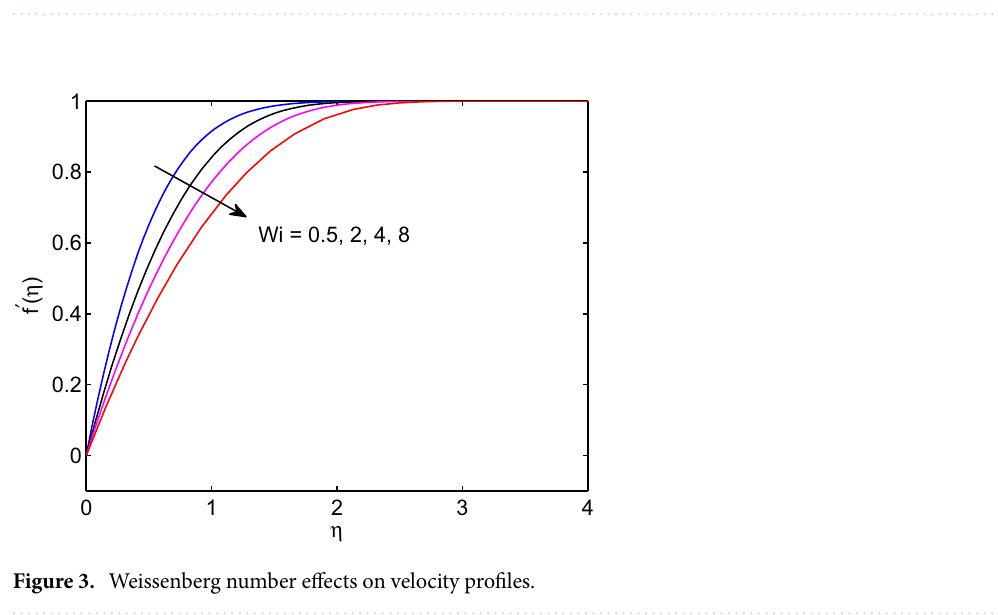
Table 2. Error analysis of shearing stress f ′′ ( 0 ) (for Pr 0 . ǫ =